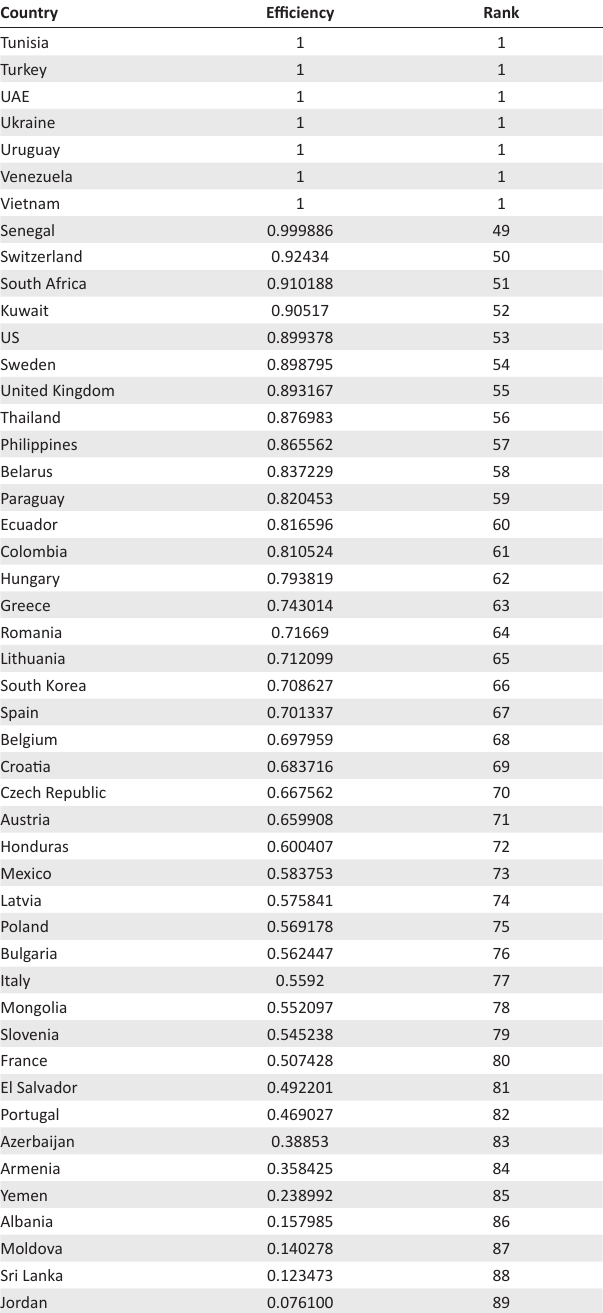
TABLE 4: Comparison of efficient versus inefficient markets.